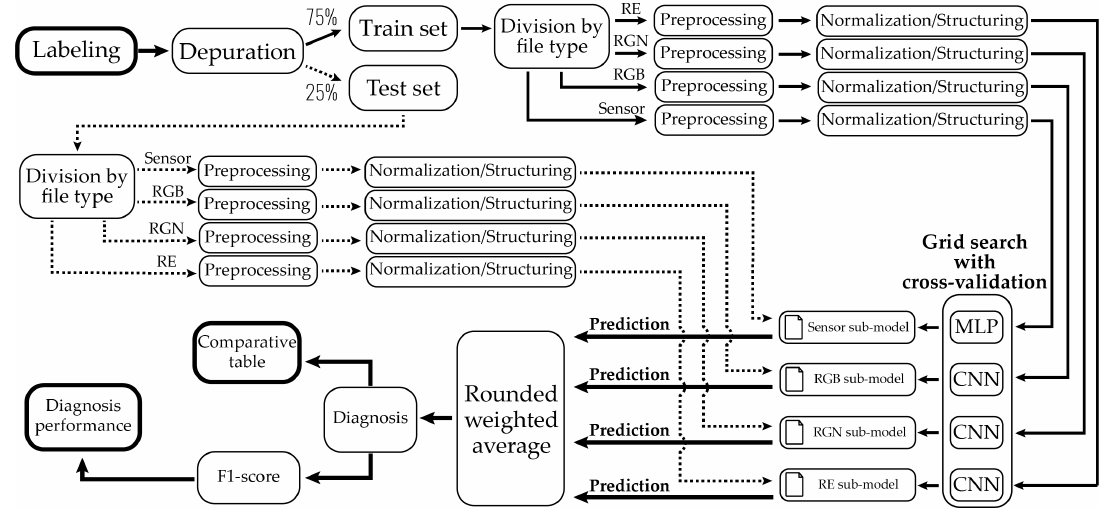
Figure 10. Machine learning summarized pipeline model.